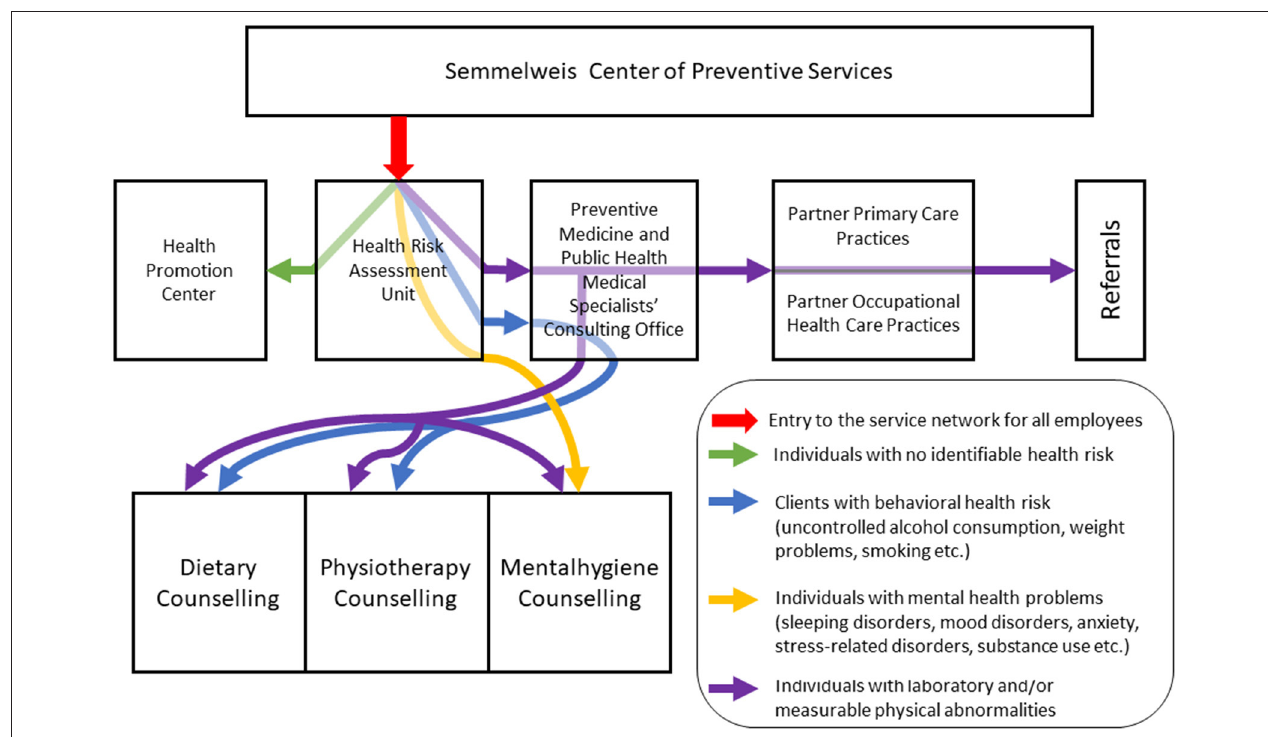
FIGURE 2 | The employees’ pathways in the Semmelweis Center of Preventive Services’